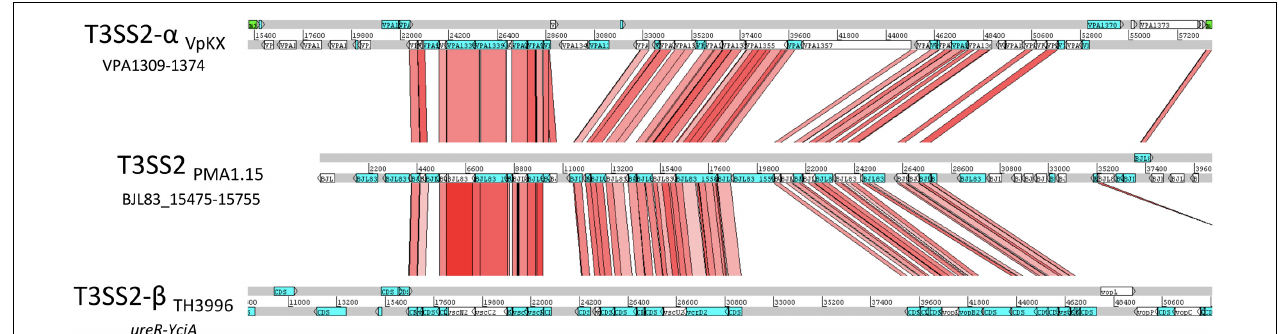
FIGURE 3 | Comparative analysis of the T3SS2 gene clusters identified in strain PMA1.15 of V. parahaemolyticus . Translated DNA-based comparison of the T3SS2 gene cluster of PMA1.15 and the T3SS2- α and T3SS2- β of the VpKX and TH3996 strains of V. parahaemolyticus , respectively. TBlastX analysis was performed using WebACT and displayed with the ACT